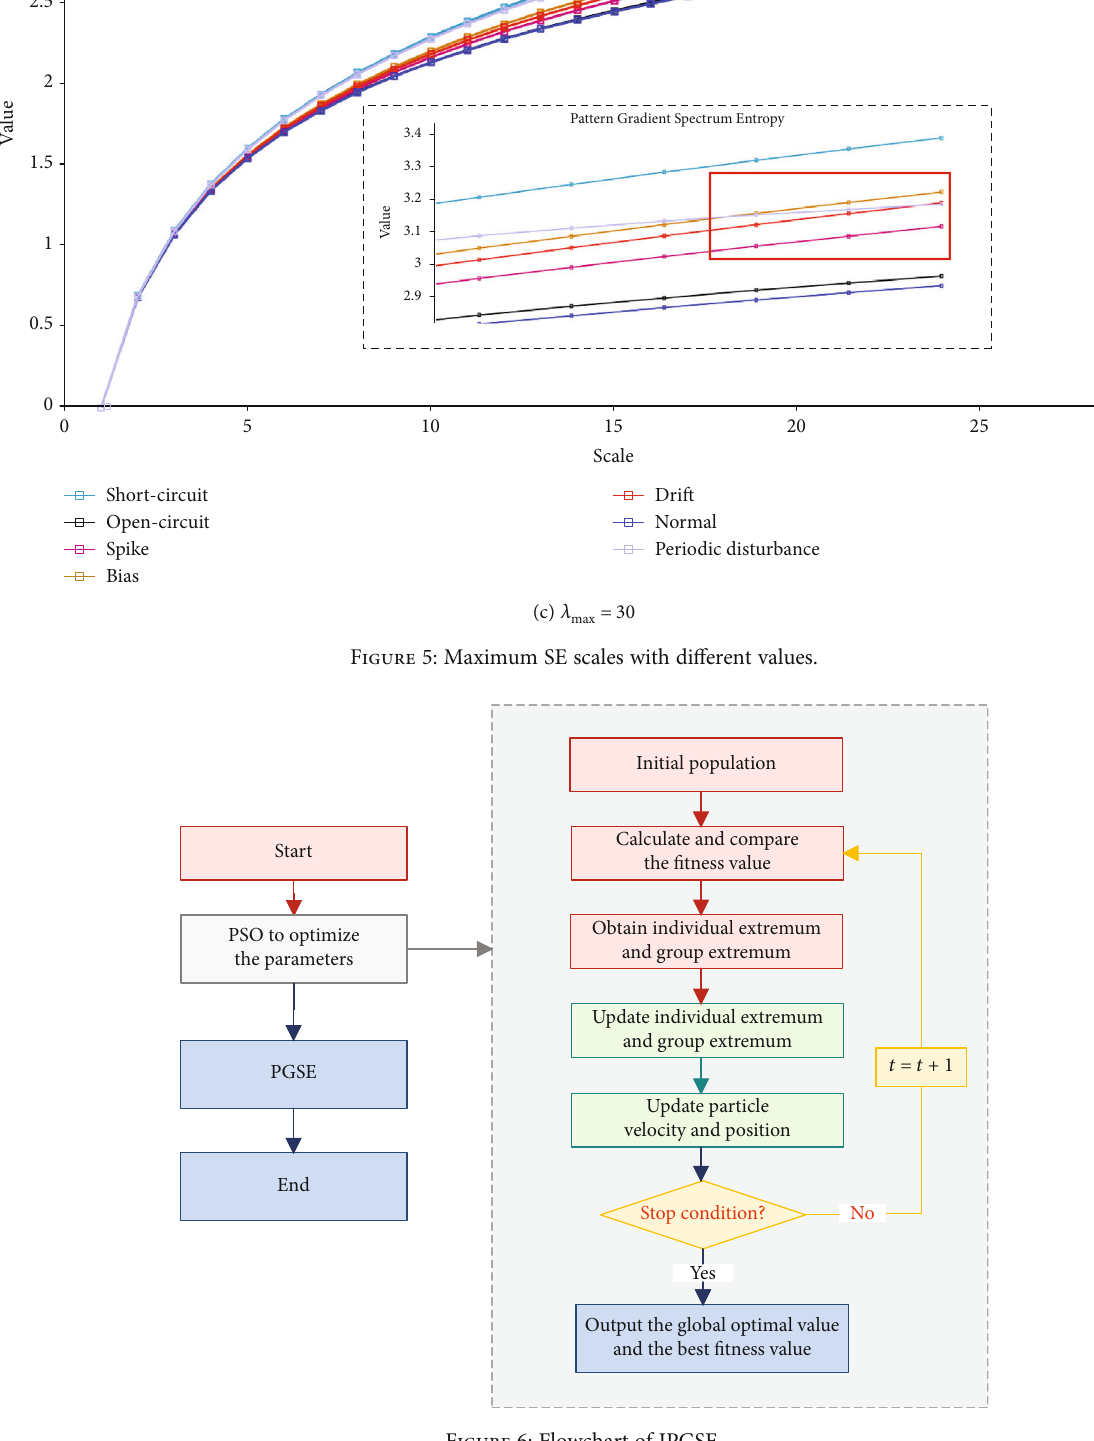
Figure 6: Flowchart of